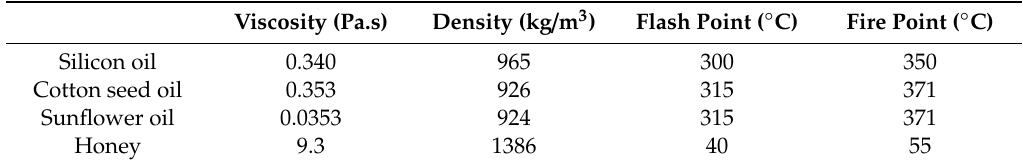
Table 1. Physical properties of components of carrier fluid blends.